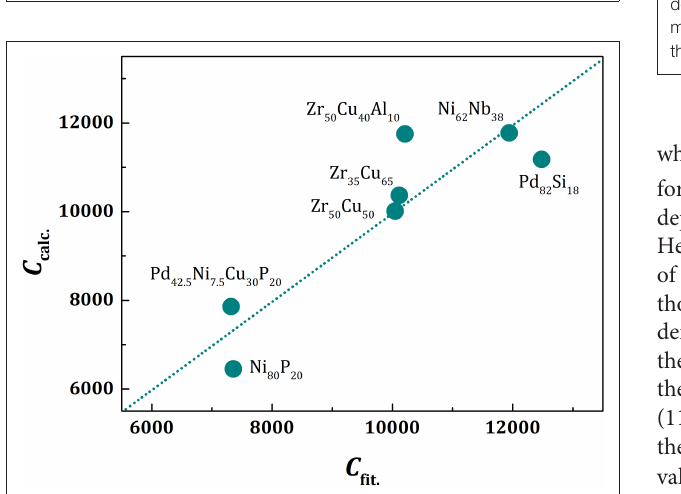
where d ( T ) = 3 for T < T g , d ( T ) =